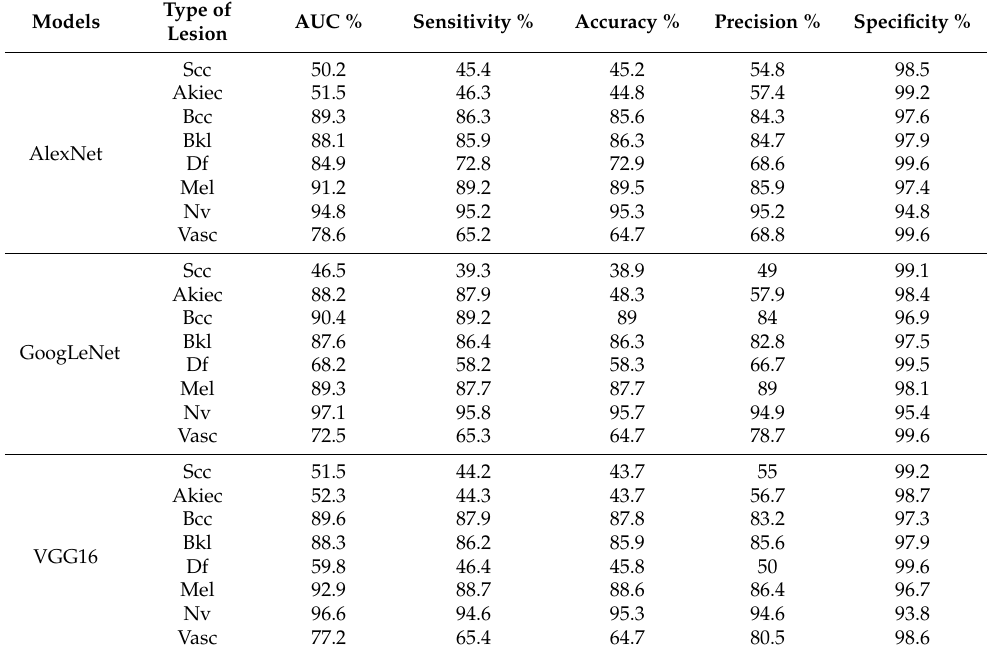
Table 3. Performance results of pre-trained CNN models for analysis of the ISIC 2019 dataset image for early diagnosis and differentiation of skin cancer and other skin